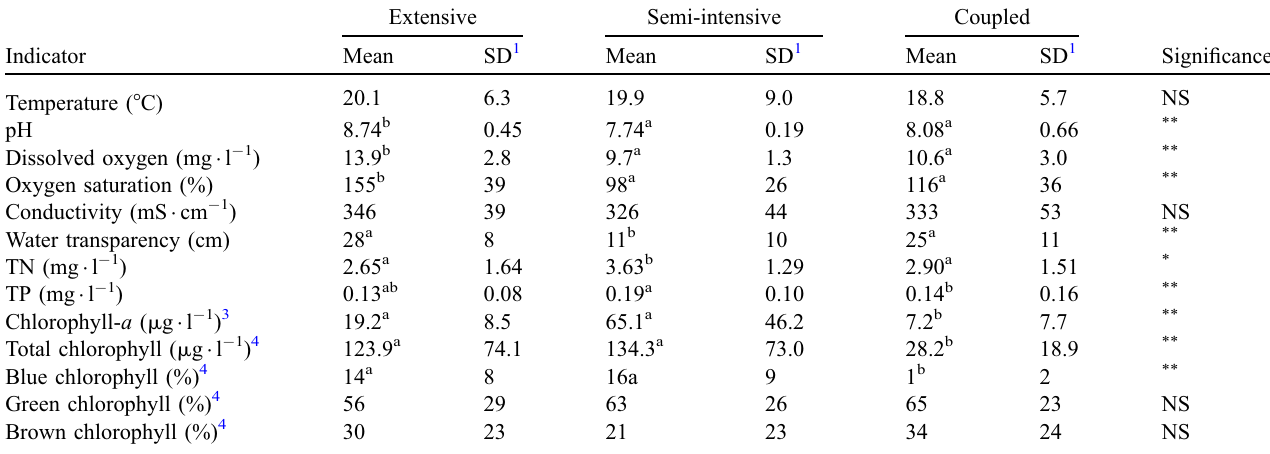
From March to June. 4 From July to